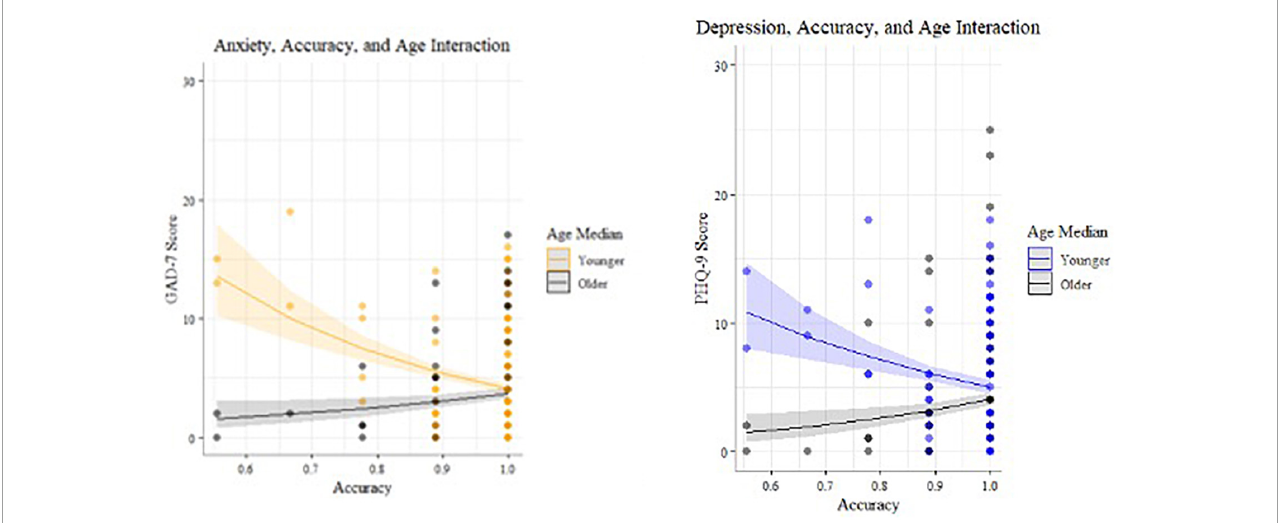
FIGURE8 Statistically significant interactions predicting anxiety and depression for incongruent Visual Search (median split by age for visualization purposes).